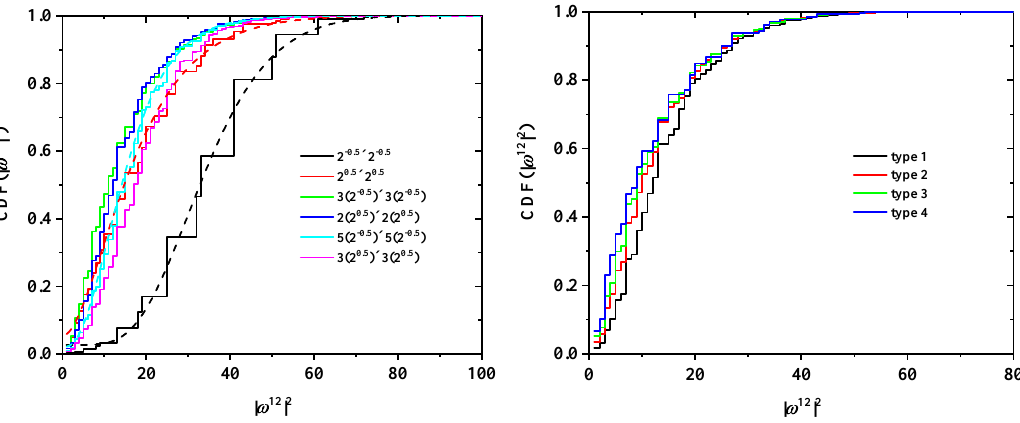
(cid:12) (cid:12) 2 for SAWs of fixed length (cid:12) ω 12 (cid:12)